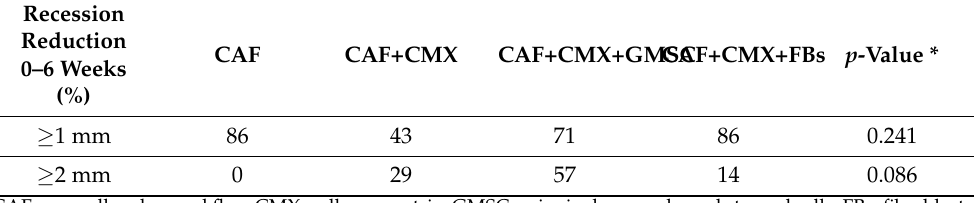
Table A2. Frequency Distribution (%) of Teeth with ≥ 1 mm and ≥ 2 mm Recession Reduction between Baseline and 6 Weeks (Second Healing Time).